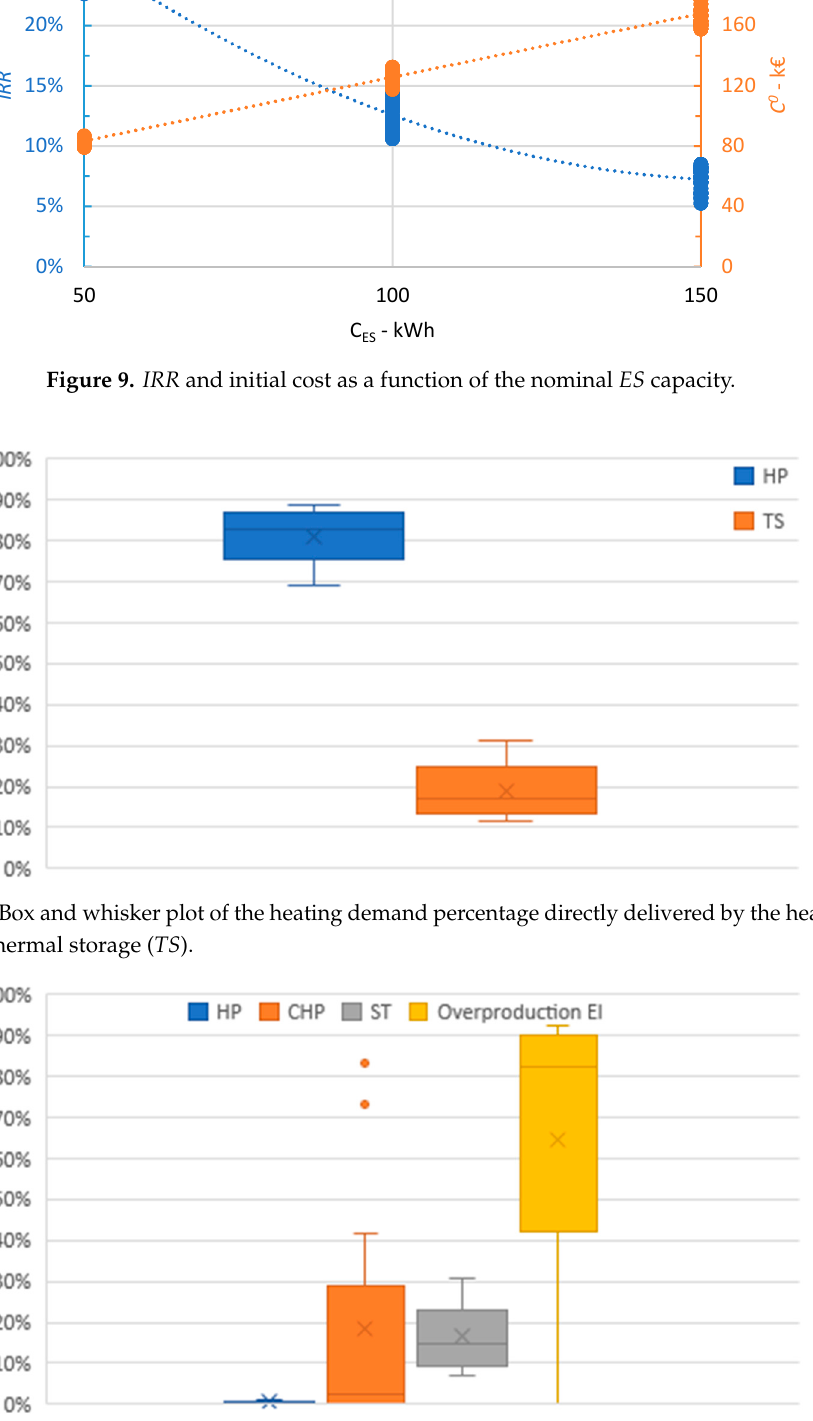
Figure 11. Box and whisker plot of the energy percentage delivered to the thermal storage by the different sources.